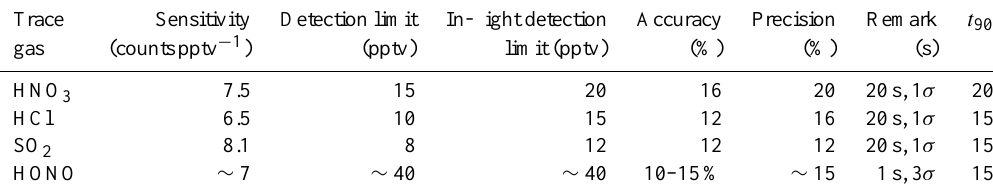
Table 1. Typical parameters describing the measurement range and data quality of AIMS-TG. Actual values may differ slightly due to optimization for one specific trace gas. Remarks concern the parameters (time resolution, standard deviation) used to determine the precision and detection limit. The precision is given for HCl, SO 2 and HNO 3 > 0 . 5ppbv. The response time t 90 is the time until 90% of a stable background or calibration signal is reached.